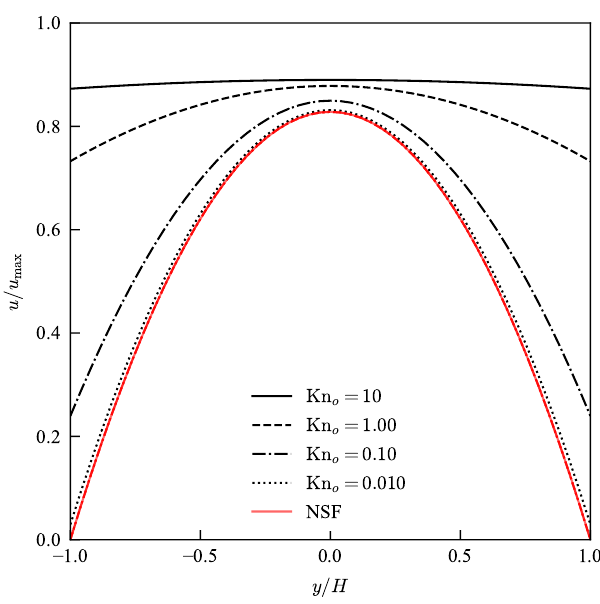
Figure 5. (Color Online) Comparison of normalised stream-wise velocity plotted as a function of normalised height, y / H , at location X = 0.9 along the micro-channel, for various Knudsen numbers as predicted by current model (in black) and N-S with no-slip condition (in red). The velocity profiles are normalised with the corresponding maximum value for each case which corresponds to the exit velocity along the center-line of the